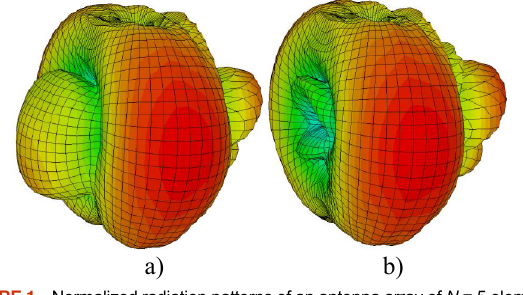
FIGURE 1. Normalized radiation patterns of an antenna array of N = 5 elements without specially created zeros (a) and with one generated synthesized (b).